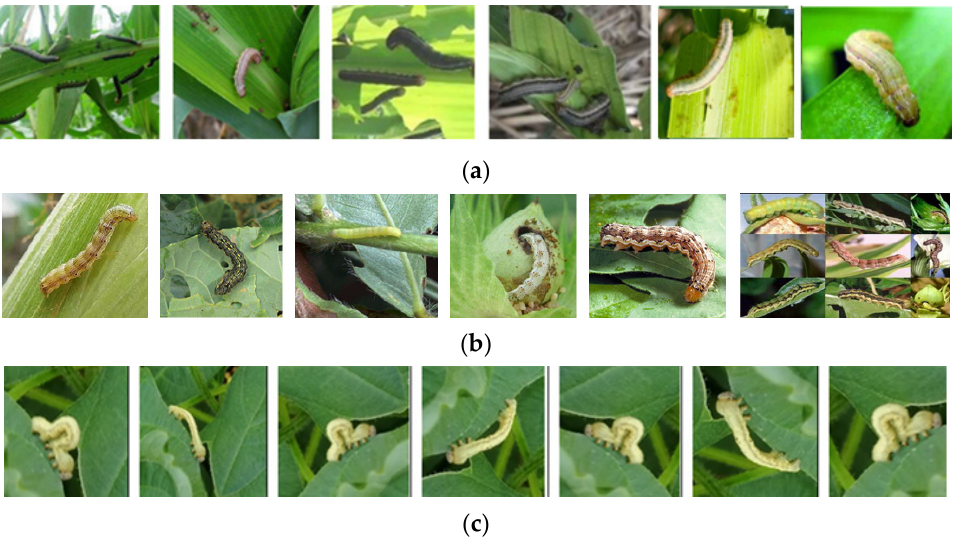
Figure 1. Crop insect pest image examples. ( a ) Maize army worm. ( b ) Cotton bollworm. ( c ) Bean larvae.